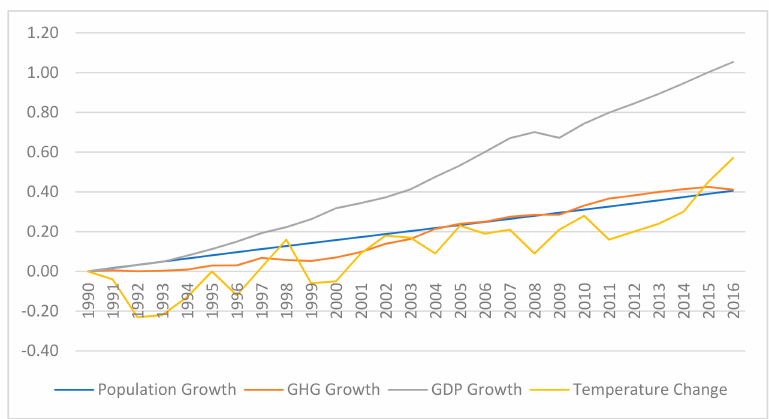
Figure 1. Historical World Data for Population, GHG Emission, Real GDP, and